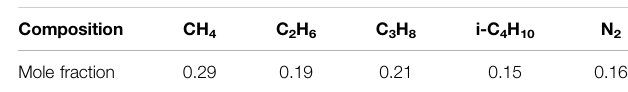
TABLE 1 | Molar composition of freezing mixture.